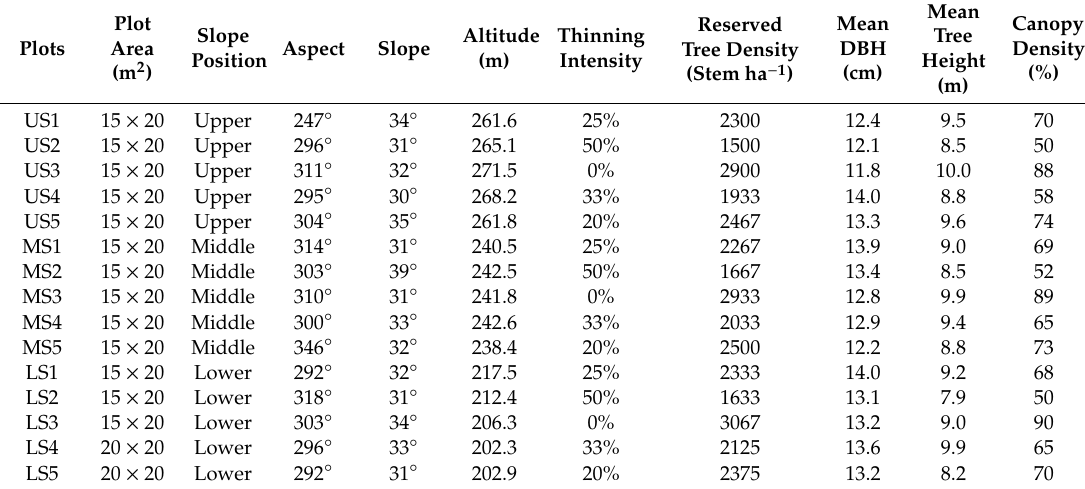
Table 1. Basic conditions of